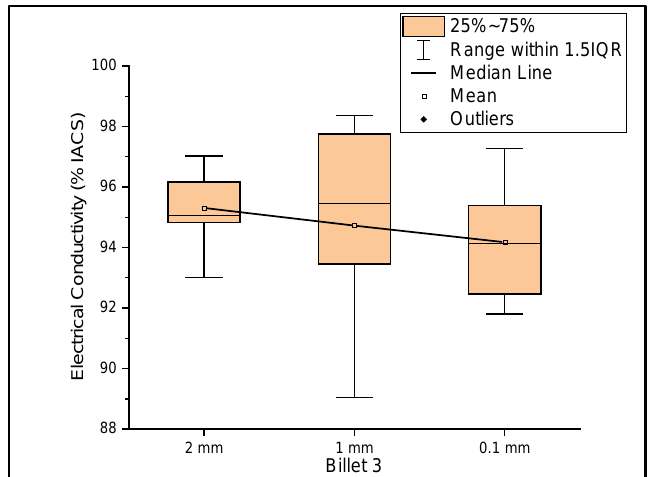
Figure 3 . The electrical conductivity of Billet 3 at different cross-sectional sizes. Figure 3. The electrical conductivity of Billet 3 at different cross-sectional